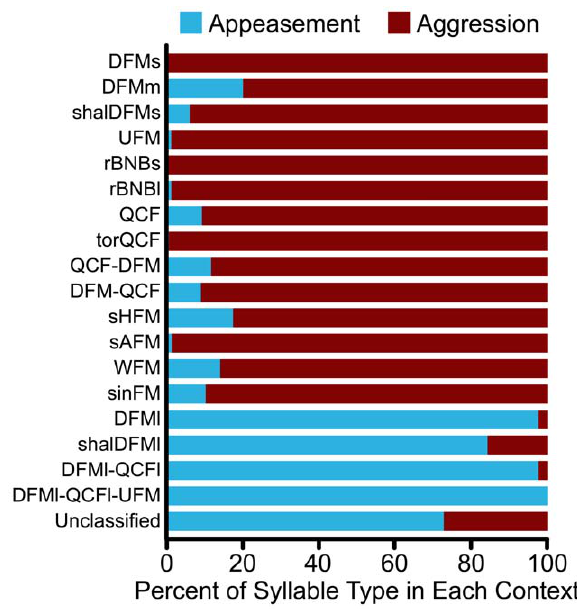
Figure 2. Occurrence of syllable types during aggression or appeasement. For all classified syllable types, more than 80% of observed syllables were emitted in a particular context, aggression ( red ) or appeasement ( blue ). We therefore classified these syllables as corresponding to the predominant behavioral context.